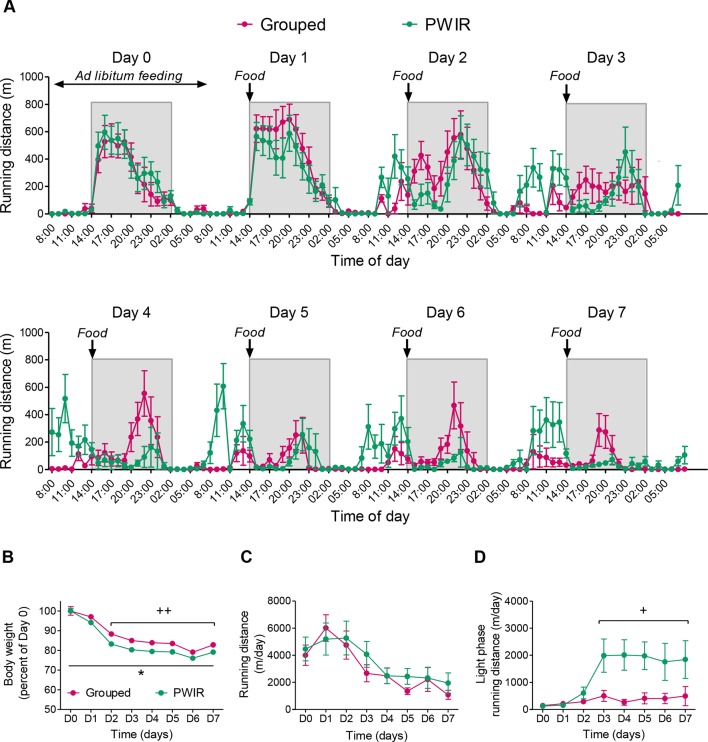
Wheel-running performances of grouped and post-weaning isolation reared (PWIR) female mice submitted to a restricted feeding protocol. (A) Hourly wheel-running activities before and during repeated food restriction (days 1–7). A limited amount of food (50% of the food quantity consumed during ad libitum feeding conditions) was provided at the daily onset of the dark period of the light/dark cycle. (B) Food restriction-elicited body weight reductions in grouped and PWIR mice. (C,D) Food restriction effects on daily running distances (C) and on daily distances ran during the light part of the light/dark cycle (D). The values are the mean ± standard error of the mean of n = 7–8 mice. * p < 0.05 for the impact of PWIR (multiple-way analysis of variance). + p < 0.05 and ++ p < 0.01 for the difference with D0 (post hoc Tukey test following a significant day × mouse group interaction in the multiple-way analyses of variance). D0–D7 refer to day 0–day 7.